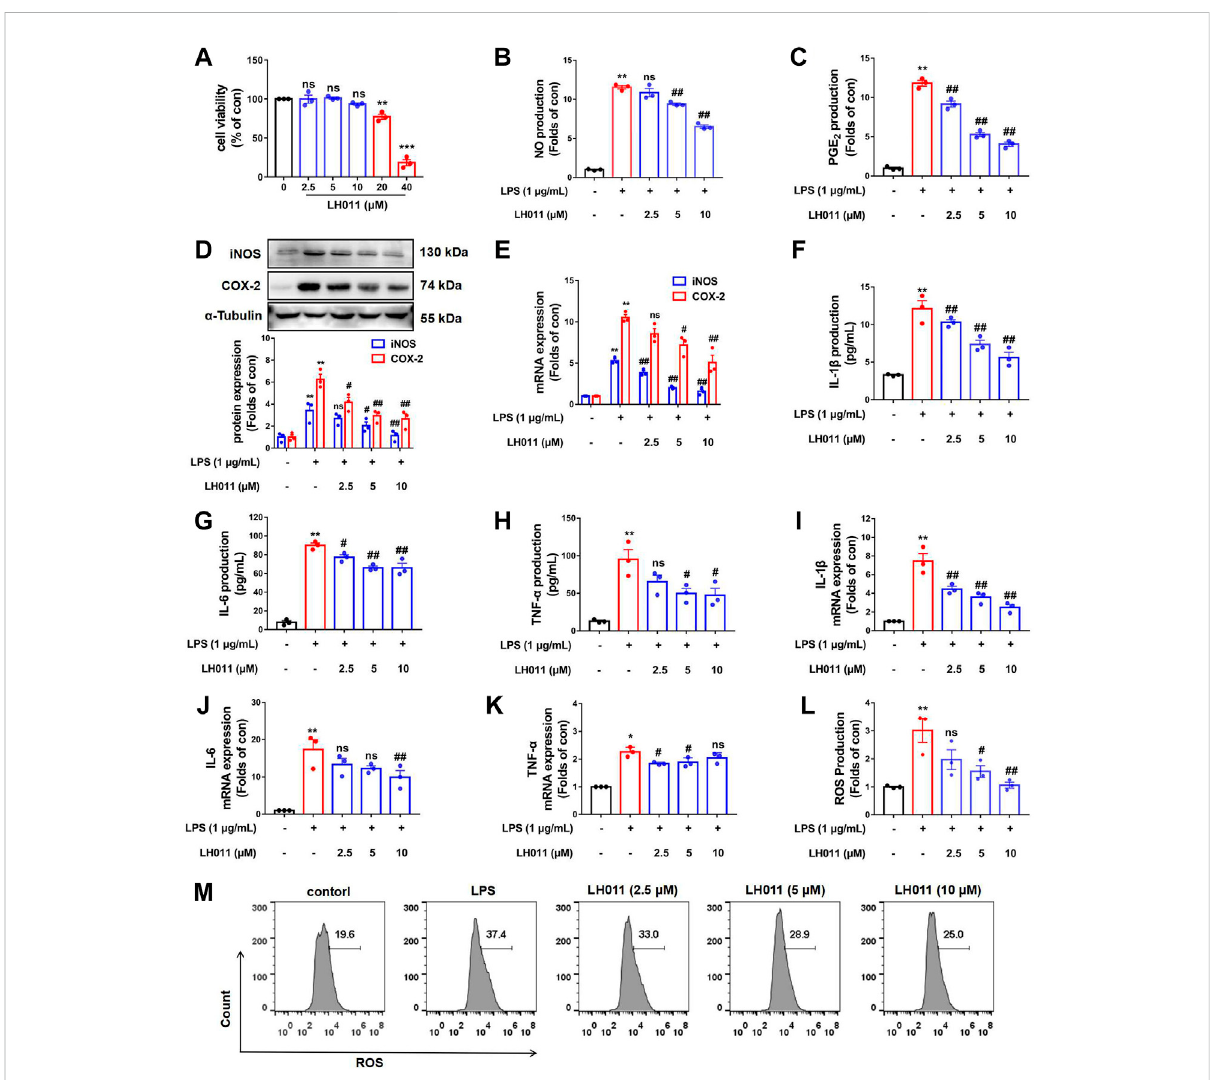
FIGURE 3 Effects of LH011 on the LPS-induced injury in RAW 264.7 cells. (A) RAW 264.7 cells were stimulated with different concentrations of LH011 for 24 h and cell viability was measured. (B,C) Concentrations of NO and PGE 2 in the cultured medium were measured. (D) Protein levels of iNOS and COX-2. (E) mRNA levels of iNOS and COX-2. (F – H) Production of IL-1 β , IL-6, and TNF- α . (I – K) mRNA levels of IL-1 β , IL-6, and TNF- α . (L,M) Intracellular levels of ROS were detected by fl ow cytometry. All data are presented as the mean ± SEM (n = 3). * p < 0.05, ** p < 0.01, *** p